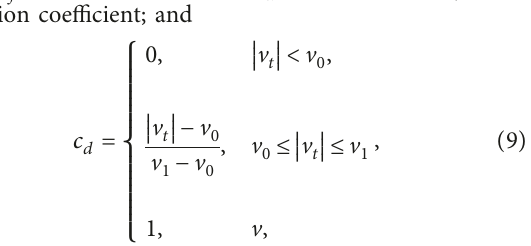
Figure 2: Revolute joint with clearance.